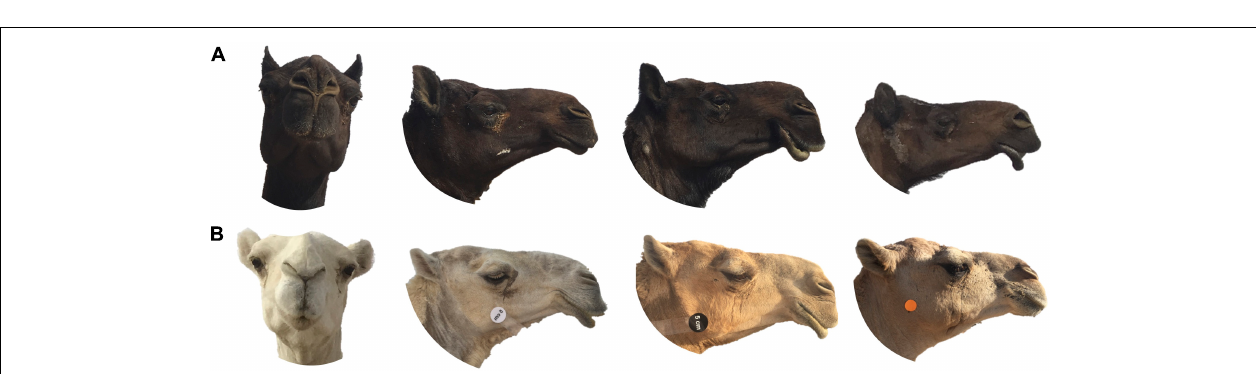
FIGURE 4 | Ear length and shape variation between Mezayen camel breeds. (A) Majaheem camels have a distinct long-pointed ear shape, referred to as “speared” ears, whereas (B) Malaween breeds (Sofor, Shaele, Homor, Shageh, and Waddah) all exhibit shorter ears that are “folded” or “tilted” sideways and to the back. The white and black disks are five centimeters in diameter, which were added to extract a scale factor in subsequent morphometric analyses. Images were extracted from Cdrom Archive photos (collected by the authors).